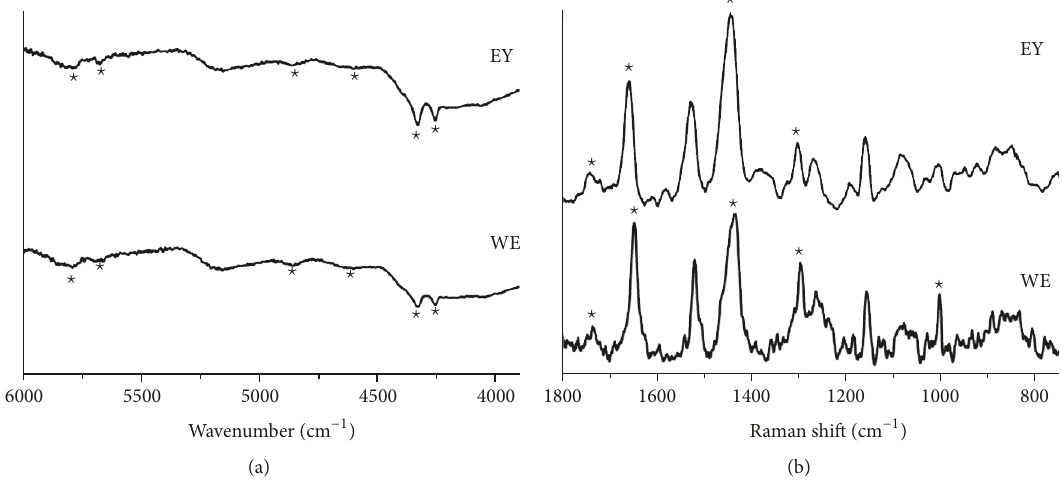
Figure 2: FT-NIR (a) and Raman (b) spectra of egg yolk-EY and whole egg-WE. Raman spectra are presented after background subtraction. Star symbols point to some specific spectral features discussed in the text. The assignments of the FT-NIR and Raman spectra are reported in Tables S3 and